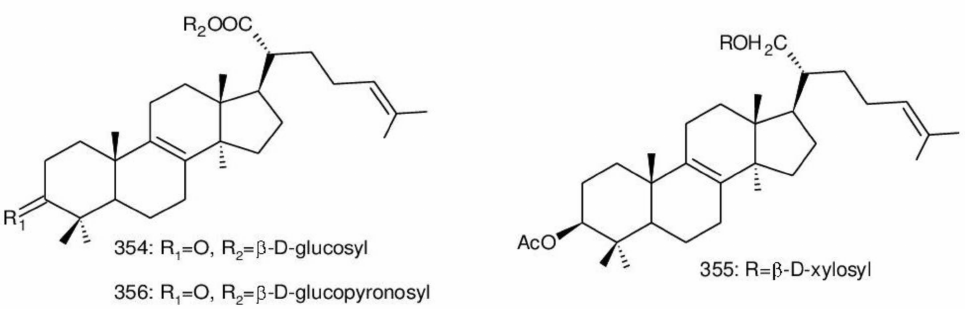
Figure 11. Chemical structures of several triterpenoid saponins ( 354 – 356